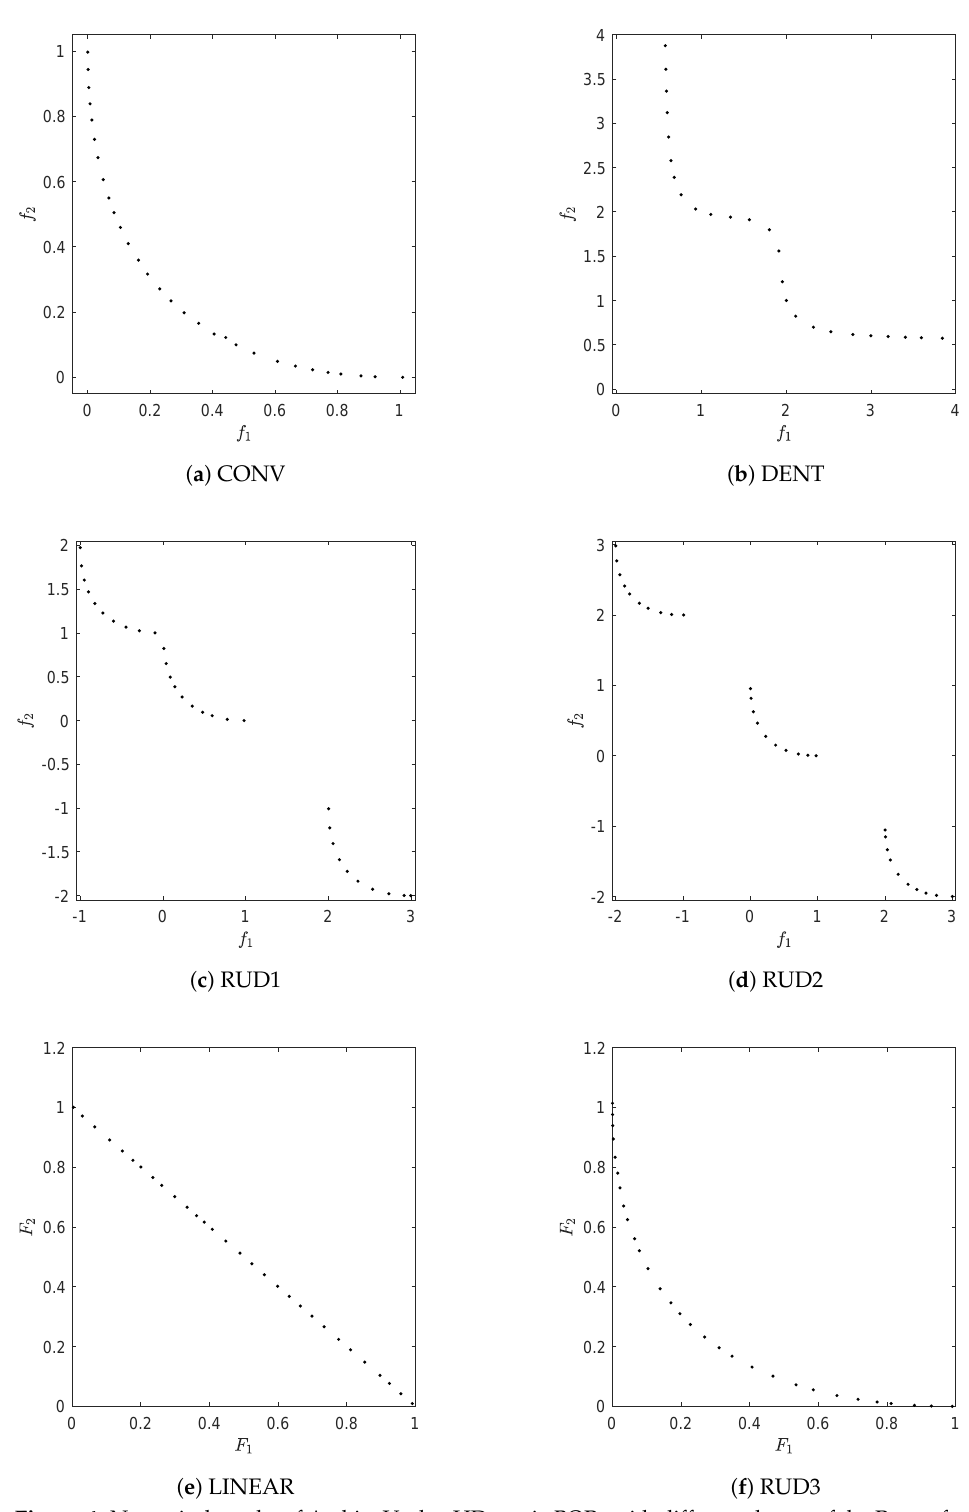
Figure 4. Numerical results of ArchiveUpdateHD on six BOPs with different shapes of the Pareto fronts. For the sake of clarity, we omitted the fronts that already become apparent by the